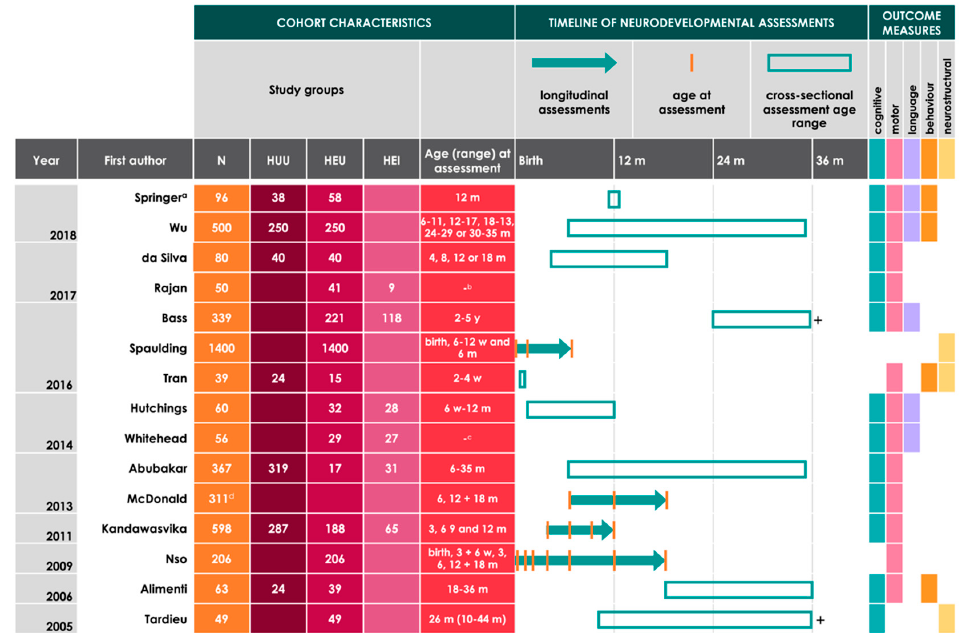
Figure 1. Adapted Graphical Overview for Evidence Reviews (GOfER) diagram [34] of studies reporting on neurodevelopmental outcomes in infants in relation to HIV-exposure status. A plus sign (+) beside the timeline bar indicates that assessments were performed for infants beyond 36 months of age. HUU = HIV-unexposed, uninfected; HEU = HIV-exposed, uninfected; HEI = HIV-exposed, infected; d = days; w = weeks; m = months; y = years. a Two studies report on data from the Mother and Infant Health Study (MIHS) cohort [48,52]. b Development was assessed for all children at enrolment (range 6–18 m) and after 3 months. A third assessment was done for 25 children after 6 months of enrolment. c Infants under one year of age were eligible for recruitment. Neurodevelopment was assessed at baseline (prior to initiating ART for infants who were HEI) and again three and six months later. Breakdown of infant ages at baseline, second, and third assessments was not provided. d A breakdown according to infant HIV status for the 311 infants who had neurodevelopmental assessments was not available. All were HIV-exposed. One hundred and thirty-nine HEI and 519 HEU assessments were used in analysis for both cognitive and motor outcomes (repeat measures for infants were included). Data from this infant cohort are reported in another study under review [50].